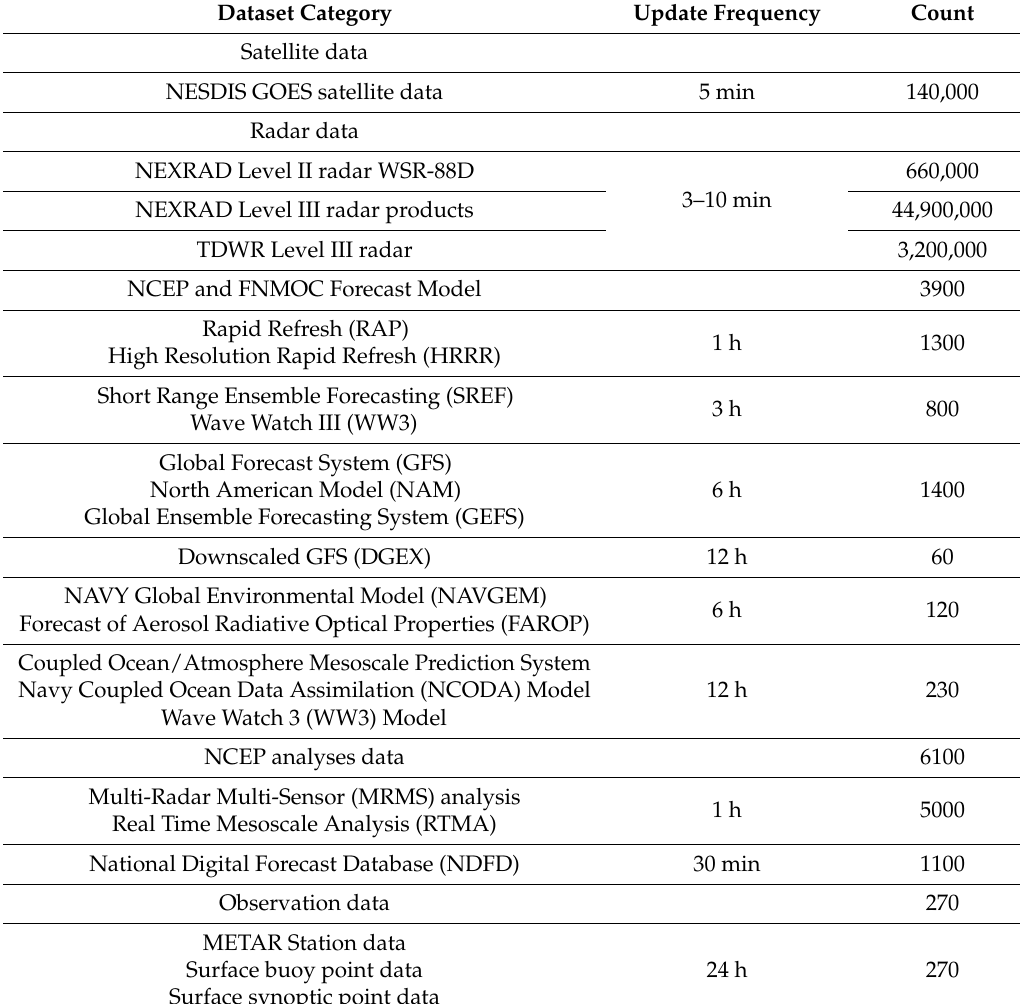
Table 2. Unidata IDD data and update